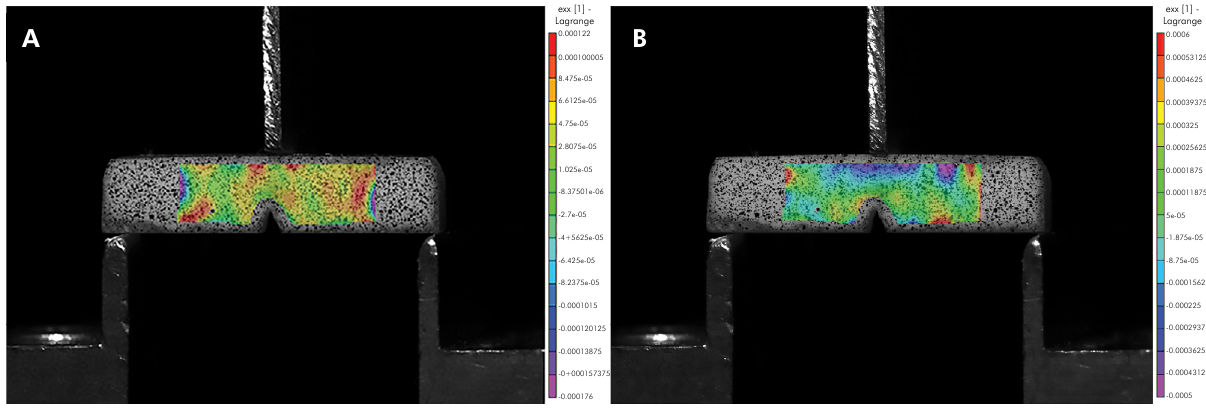
Figure 2. (a) Feldspathic ceramic strain released by the compression at the top of the specimen at the beginning of the test. (b) Below the compression area is possible to identify the strain being generated by such movement. Located above the V-notch a yellow orange area shows the tensile concentration at the exact moment before the specimen